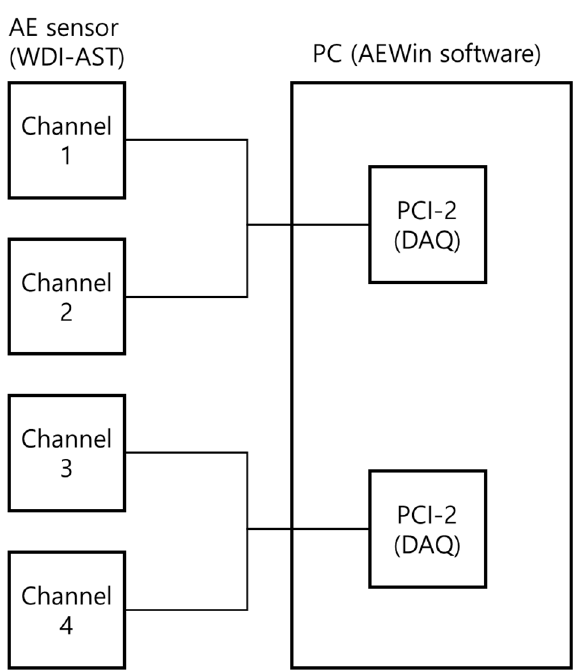
Figure 6. The data acquisition system. PC: personal computer; PCI: peripheral component interconnect; WDI-AST: wideband differential; AE sensor